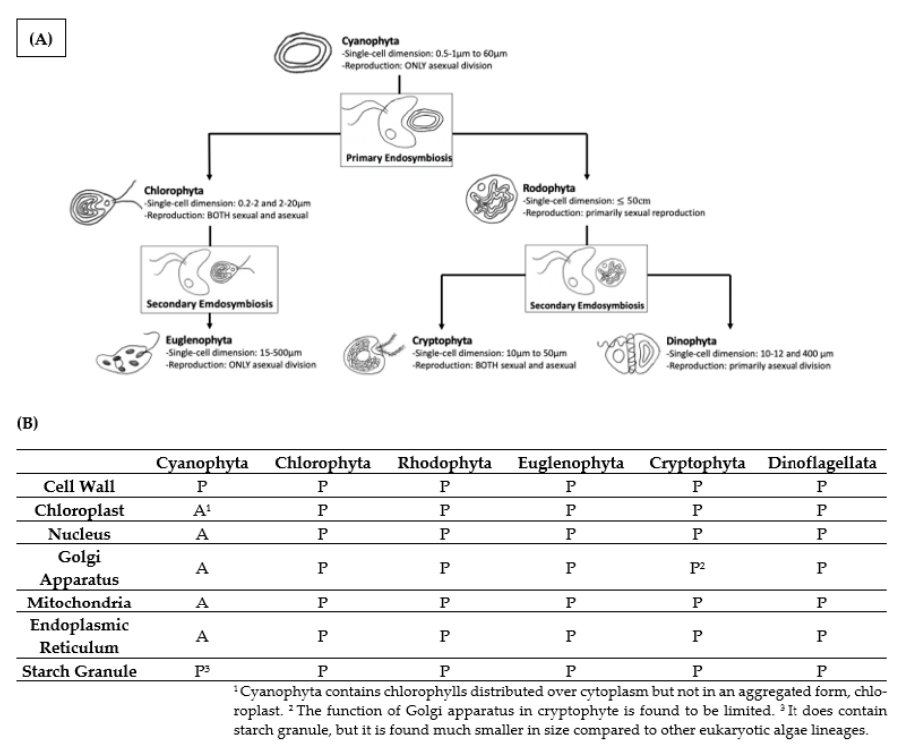
Figure 3. Cell structure of cyanobacteria and eukaryotic algae commonly seen in fresh waters and their evolutionary relationship. A: absent; P: present. ( A ) The major eukaryotic groups have risen from a common prokaryotic ancestor, Cyanophyta, via endosymbiotic events. Through the primary endosymbiosis, Chlorophyta and Rhodophyta acquired primary plastids, membrane-bound organelles usually found in eukaryotic organisms. Chlorophyta was preyed upon by a second eukaryotic cell, resulting in Euglenophyta acquiring their plastids. Similarly, Cryptophyta and Dinophyta have arisen as a result of secondary endosymbiosis on Rhodophyta. ( B ) Comparison of cellular components in six common major algal phyla. Cyanophyta shows the absence of nucleus, chloroplast, and mitochondria compared to other eukaryotic algae lineages. Cyanophyta, being the common prokaryotic ancestor, do not contain membrane-bound organelles.